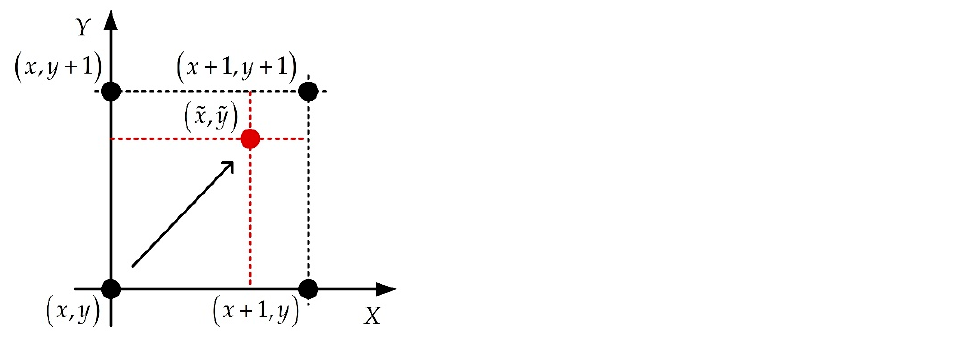
Figure 8. Illustration of the nearest neighbor interpolation algorithm, where ( x , y ) is the 2D coordinate of pixels in the original image.